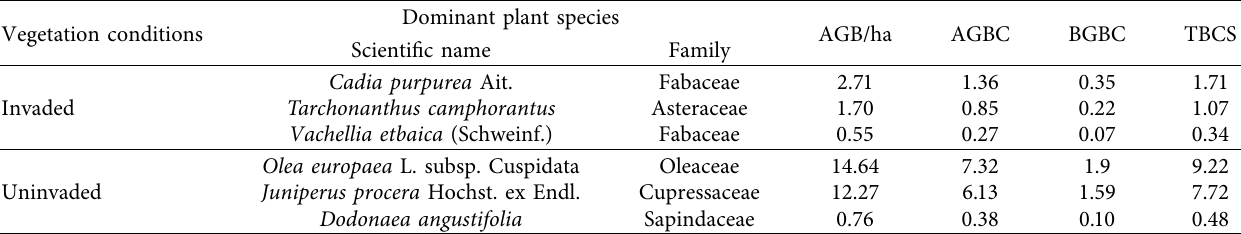
Table 1: Carbon stock’s potential of the top three dominant plant species in both invaded and uninvaded vegetation conditions. Dominant plant species Vegetation conditions